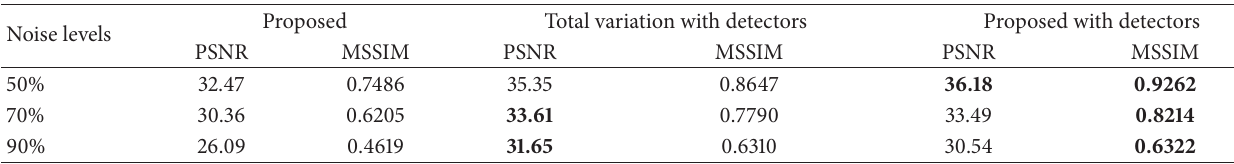
Figure 5: Denoised images with 30% salt-and-pepper noise. (a1), (a2), and (a3) are original images; (b1), (b2), and (b3) are results of median filtering; (c1), (c2), and (c3) are results of total variation denoising; (d1), (d2), and (d3) are results of the wavelet-based sparse representation denoising; (e1), (e2), and (e3) are results of the proposed method. Table 2: Denoising performance of Barbara at high salt-and-pepper noise